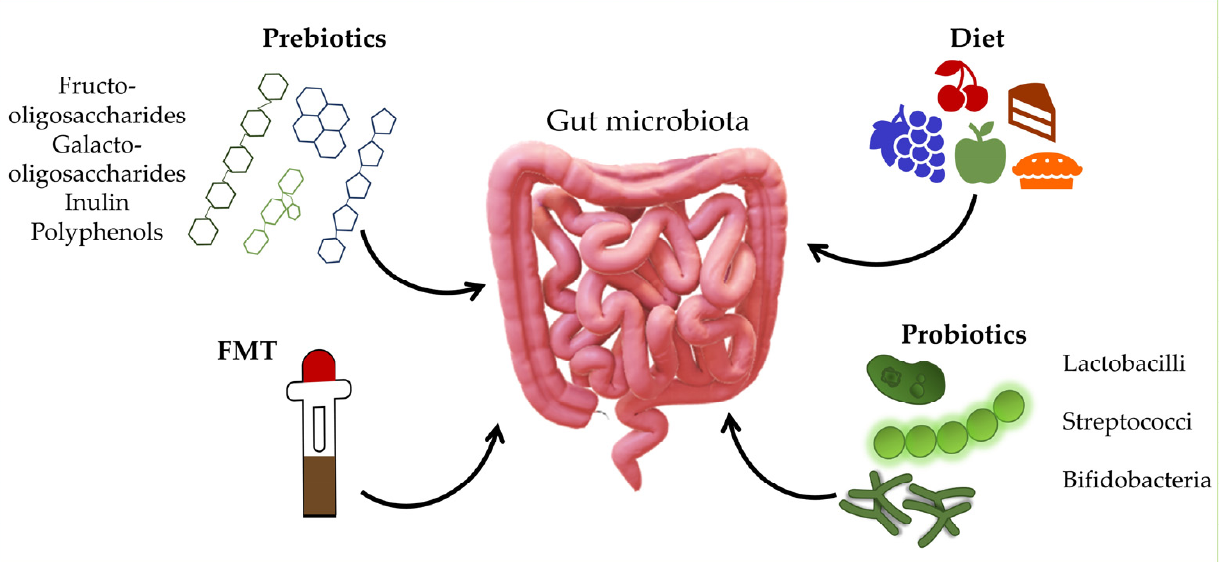
Figure 2. Schematic representation of different treatments of gut microbiota manipulation. FMT—fecal microbiome transplantation.